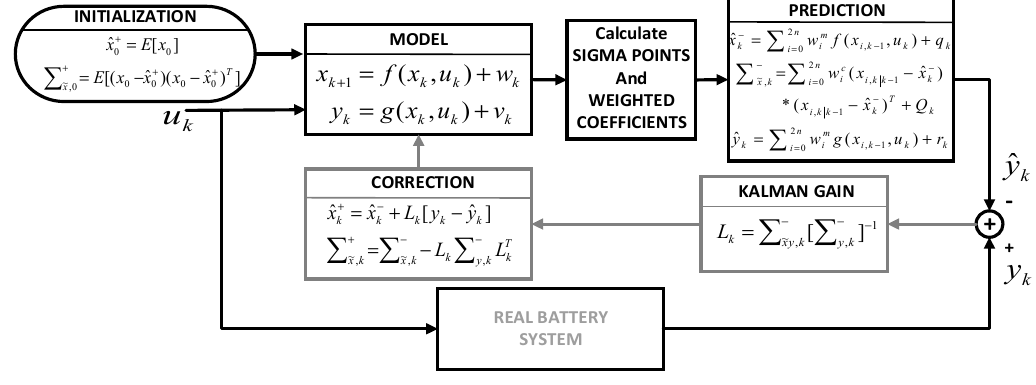
Figure 9. Unscented Kalman filter iteration diagram.